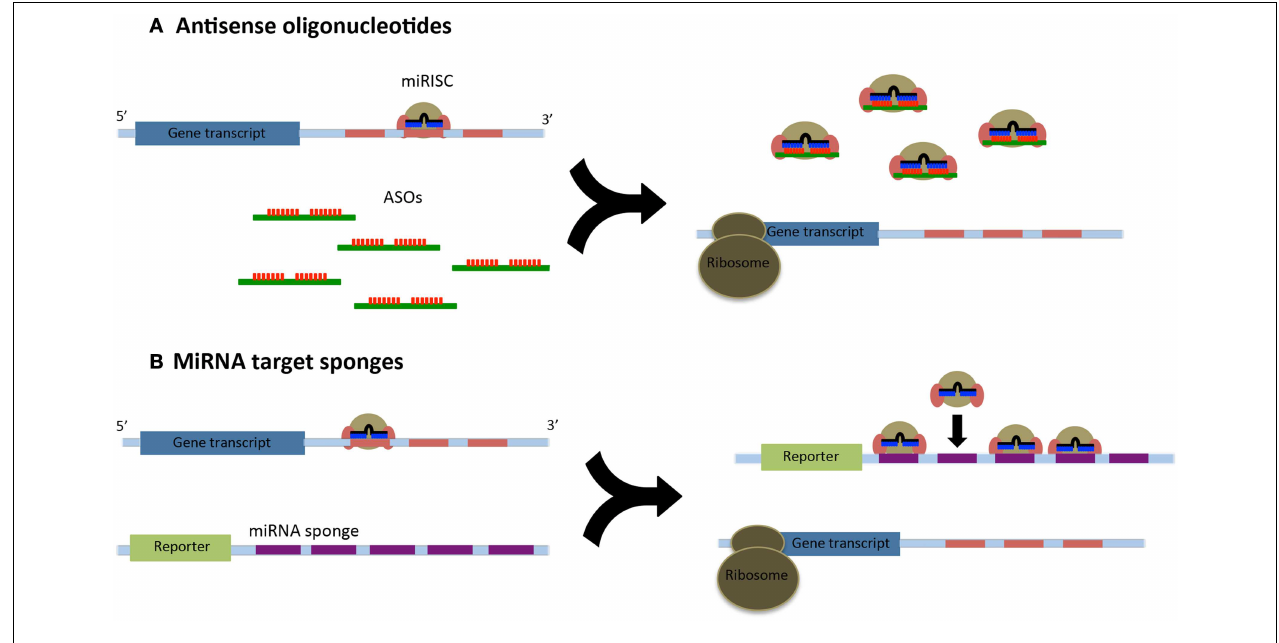
FIGURE 1 | (A) Antisense oligonucleotides (ASOs) relieve the post-translational repression of target gene transcripts through their high affinity binding to the microRNA induced silencing complex (miRISC). Many ASOs are fully complementary to their miRNAs and will lead to